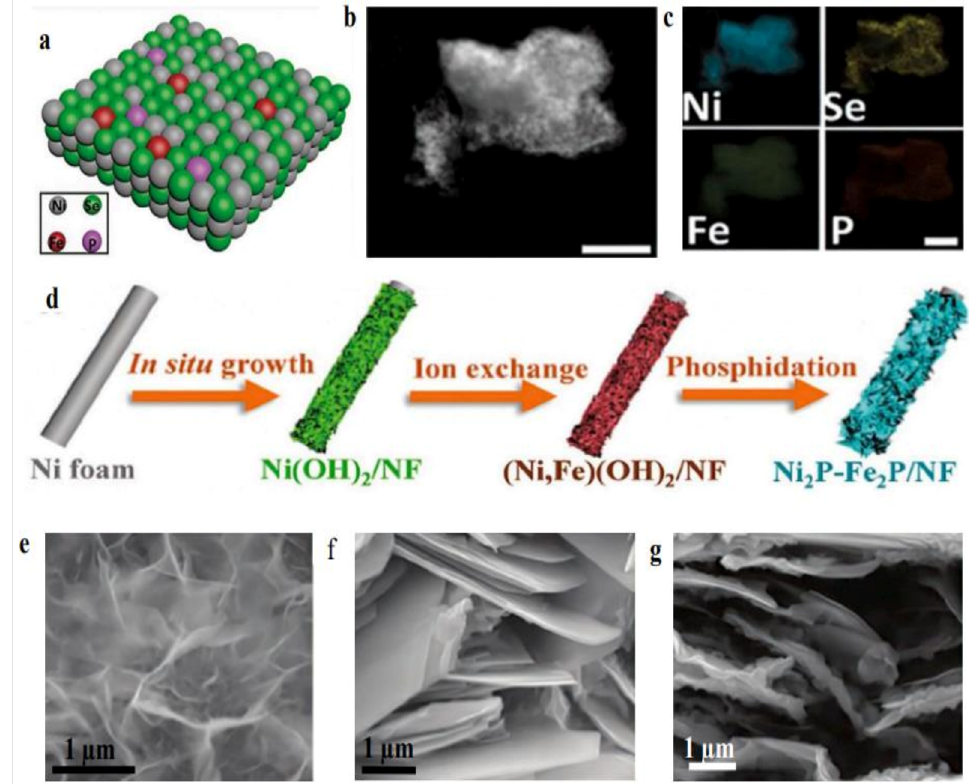
Figure 7. ( a ) Dual doped structure of NFs of Fe, P-NiSe 2, ; ( b , c ) illustrated element representations in NFs of Fe, P-NiSe 2 , reproduced from [53]; ( d ) systematic scheme for the synthesis of NFs of Fe, P-NiSe 2 ; ( e – g ) are the SEM pictures of electrocatalysts Ni(OH) 2 /NF, Ni 2 P-Ni 5 P 4 /NF, and Ni 2 P- Fe 2 P/NF, correspondingly, reprinted from